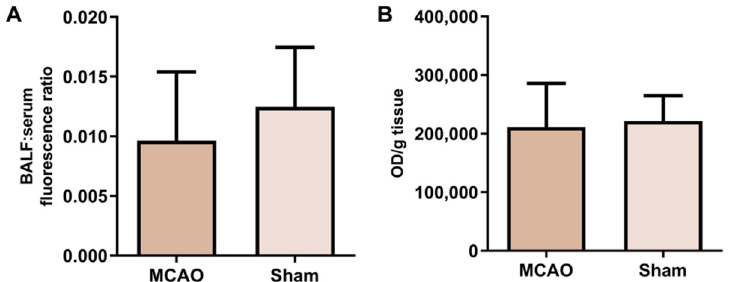
Figure 4. Lung permeability assessment. ( A ) Bar plot representing the ratio between BALF and serum fluorescence (N = 7 vs. 5). ( B ) Bar plot representing the amount of fluorescence of the tissue, adjusted by the weight of each organ (N = 7 vs. 5). For both comparisons, no significant differences were noted between MCAO and sham animals. BALF, bronchoalveolar lavage fluid; OD, optical